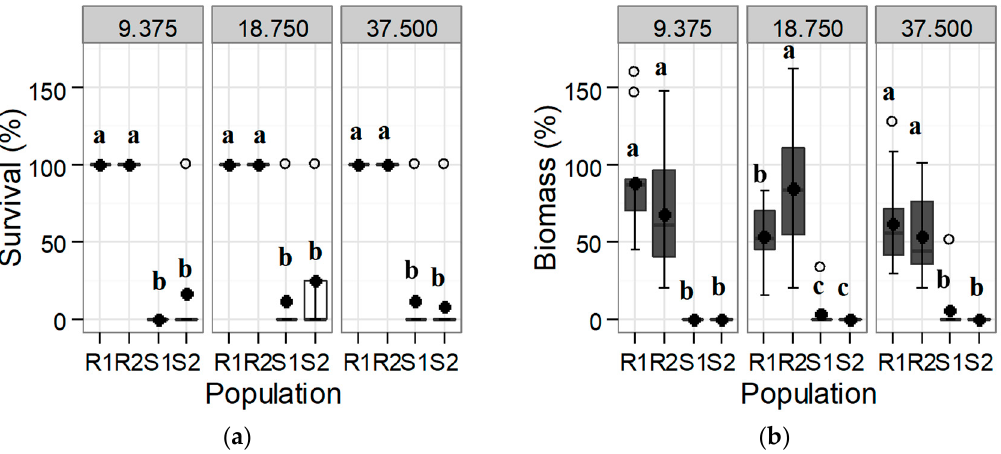
Figure 1. Box-plot showing ( a ) survival and ( b ) biomass for each of the tested Rapistrum rugosum populations compared with those of the untreated control depending on the tribenuron-methyl herbicide rate shown in the upper part of the graphs (in g a.i. ha − 1 ) 30 days after treatment (DAT). Bold points denote means, and white points denote outliers. Populations with different letters for each herbicide rate and for each parameter correspond to statistically significant differences following Tukey’s test ( p < 0.05).